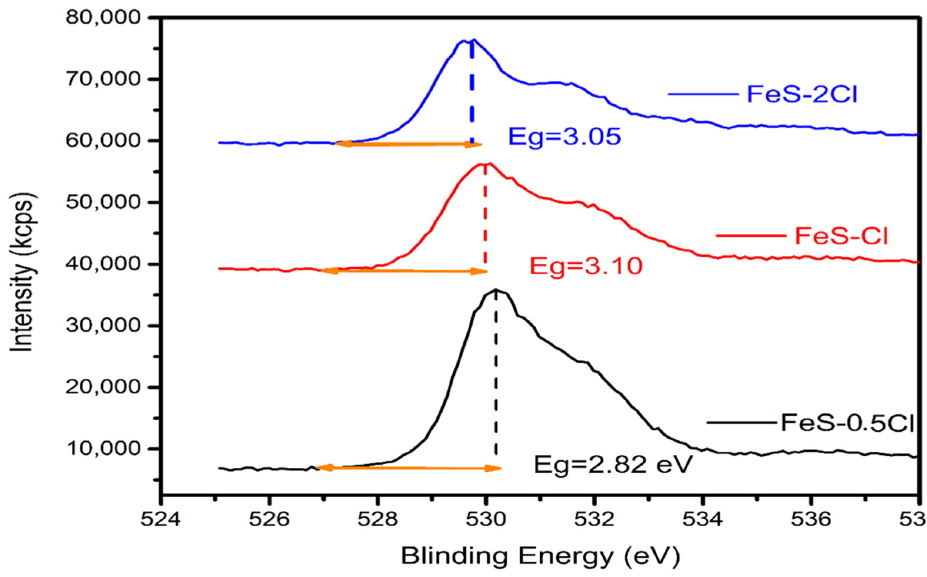
Figure 12. XPS O 1s band gap diagram, sulphur catalysts. Table 5. Oxide and sulphide areas from Fe 2p XPS spectra.